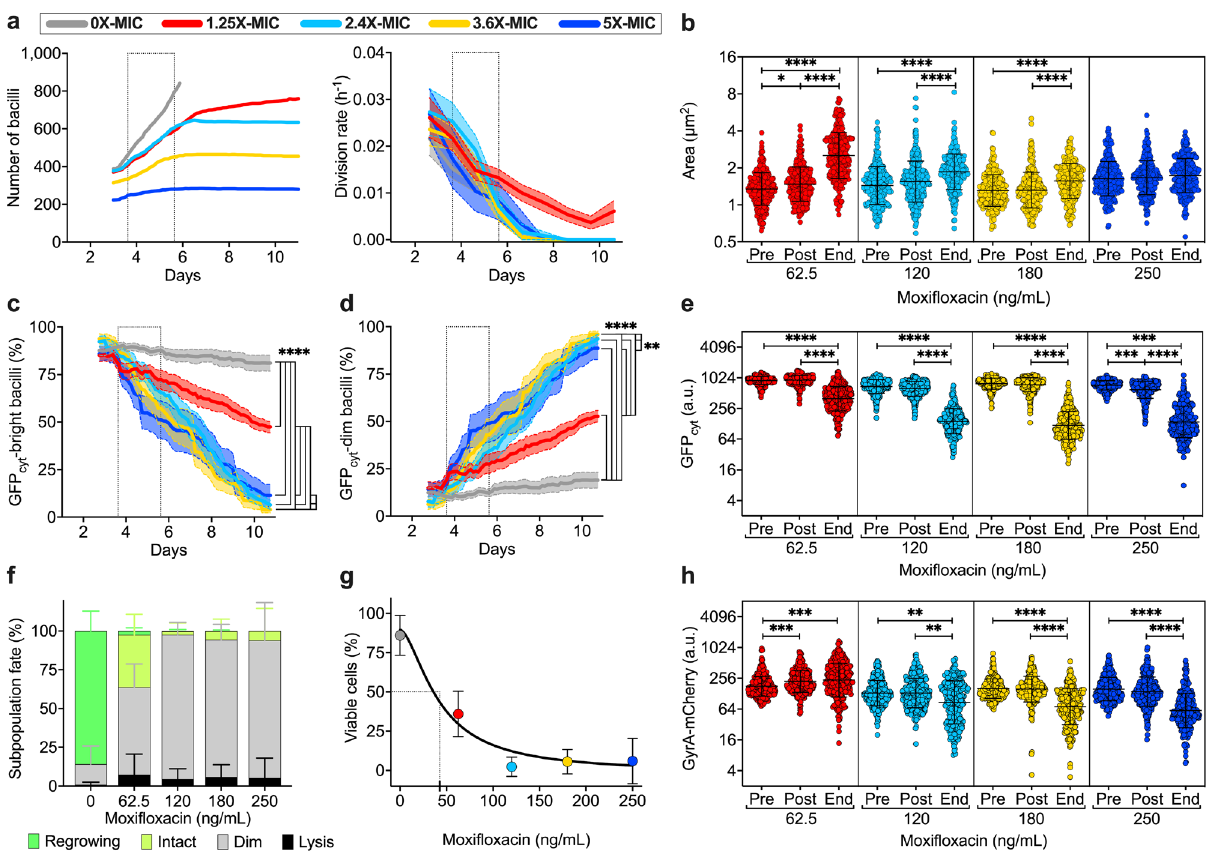
Figure 5. Effect of a static moxifloxacin gradient on M. tuberculosis GFP cyt _GyrA-mCherry reporter. ( a ) Assessment of M. tuberculosis GFP cyt _GyrA-mCherry growth during multi-phasic time-lapse microscopy. Number of bacilli (left panel) and cell division rates (right panel) in different chamber groups of the five- condition device before, during and after moxifloxacin exposure (dotted lines). Lines and error bars represent mean ± SEM (279 ≤ N ≤ 842 bacilli, from two independent experiments). Colors refer to the concentration of moxifloxacin used in each chambers group relative to the MIC (50 ng/mL) according to the dilution factors measured in Fig. 3b, as denoted in the inset. In the absence of drug (gray lines), cell count stops earlier due to excessive growth. ( b , e , h ) Single-cell size ( b ), GFP cyt ( e ) and GyrA-mCherry ( h ) fluorescence at different experimental time points just before (Pre) and just after (Post) treatment, and at the end of the recovery period (End). Black lines indicate mean ± SD (253 ≤ N ≤ 308 bacilli, from two independent experiments). Significance by one-way ANOVA followed by Kruskal–Wallis multiple comparisons test: * P = 0.05; ** P < 0.005; *** P < 0.0008; **** P < 0.0001. ( c , d ) Fractions of subpopulations over time displaying bright GFP cyt ( c ) or dim GFP cyt ( d ) fluorescence. Space between dotted lines represents the period of drug exposure. Lines and error bars represent mean ± SEM (222 ≤ N ≤ 1327 bacilli, from two independent experiments). Significance by two-way ANOVA followed by Tukey’s multiple comparisons test: ** P = 0.006; **** P < 0.0001. ( f ) Fractions of subpopulation fates at different drug concentrations (295 ≤ N ≤ 1327, from two independent experiments). ( g ) Cumulative fraction of survivors (regrowing and intact GFP cyt -bright) at the end of the recovery period as a function of moxifloxacin concentration. Symbols and error bars represent mean ± 95% CI (295 ≤ N ≤ 1327, from two independent experiments). Black line represents fitting of the data with a four-parameter dose–response curve: R 2 = 0.88; d.f. 98. The IC50 value is shown (dashed